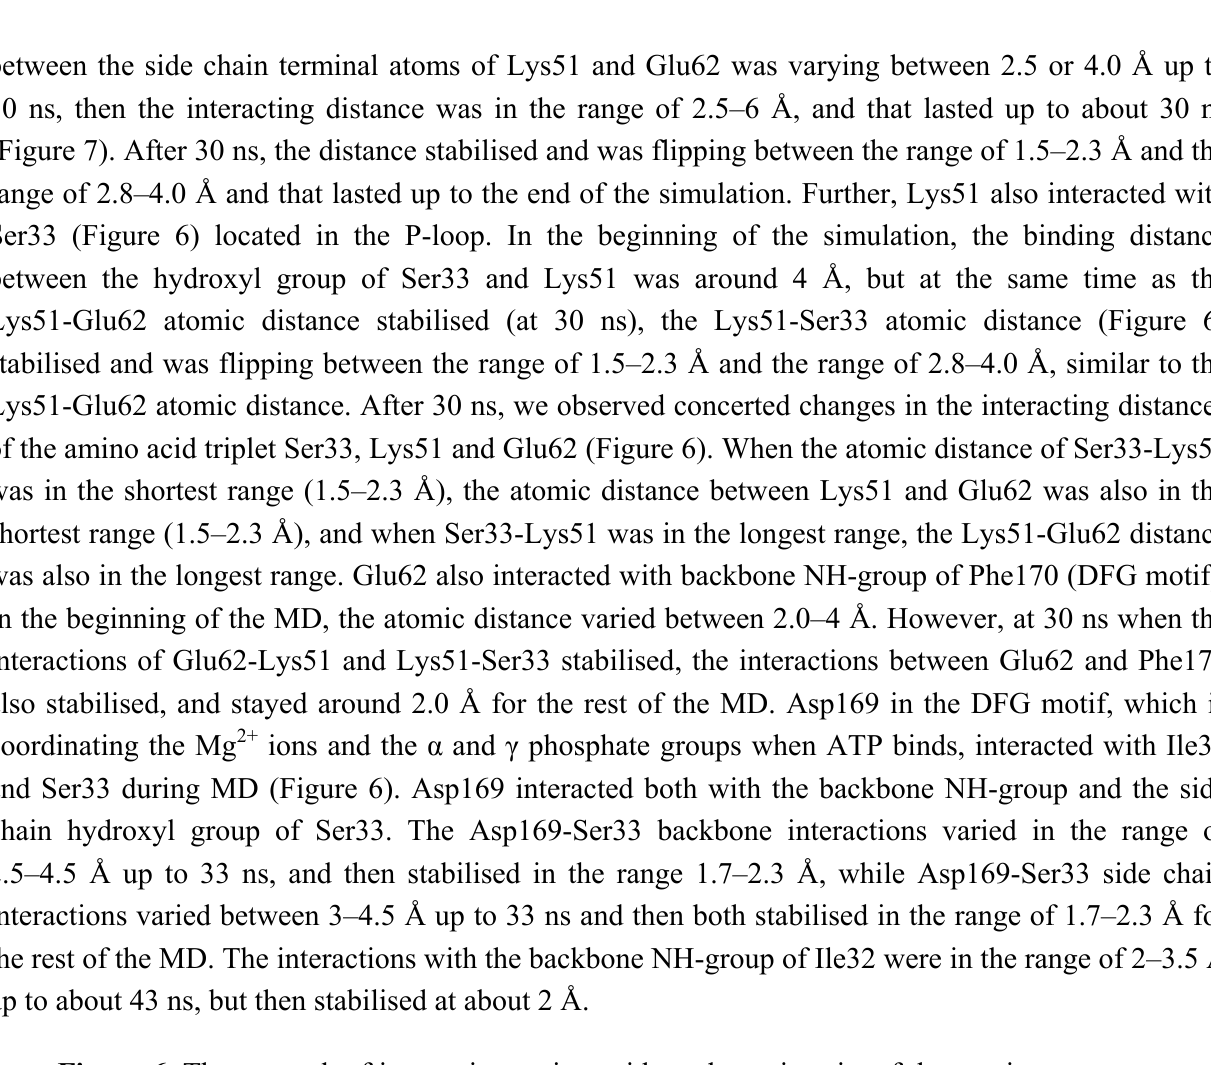
Figure 6. The network of interacting amino acids at the active site of the starting structure X-ray structure of MK3 in an active kinase conformation, and the MK5 model is therefore also in active kinase conformation. Colour coding of atoms: red; oxygen, blue; nitrogen, green; carbon atoms of the inhibitor, grey; carbon atoms of the amino acids, white; hydrogen atoms. Dotted lines are showing observed interactions between amino acids during MD of the free MK5 and the MK5-inhibitor